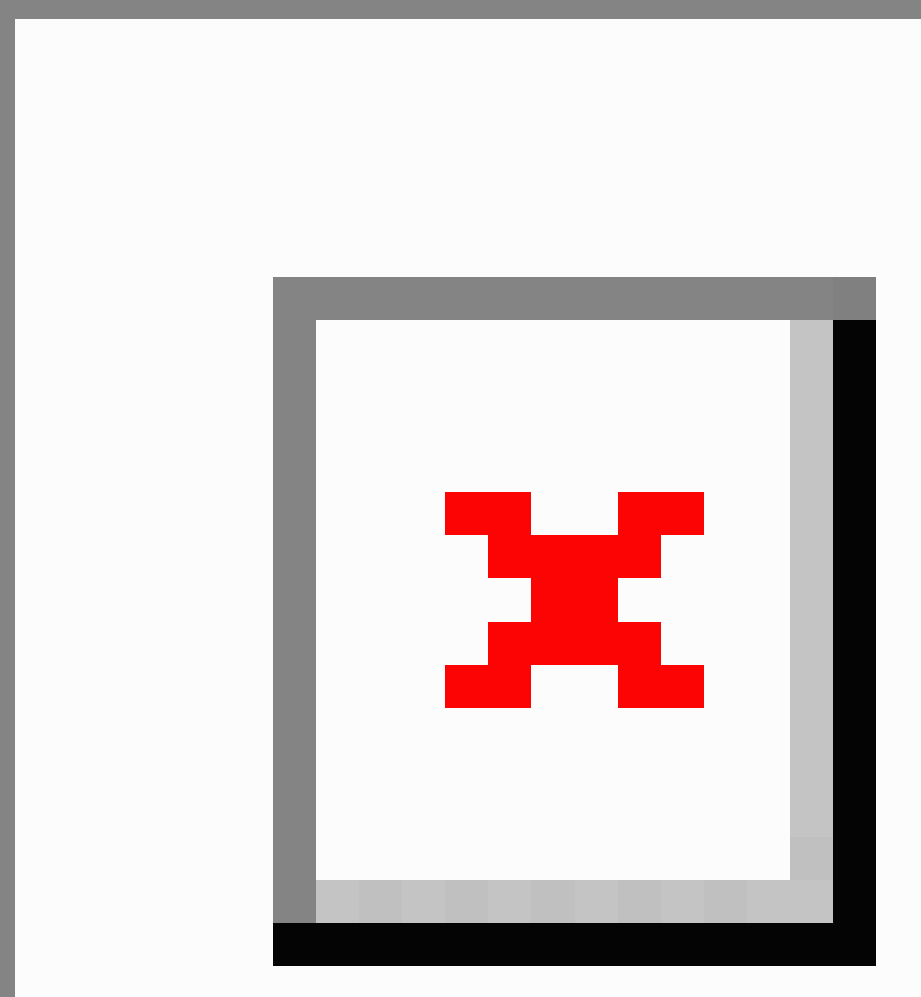
Figure 3. The importance rankings of feature variables for the XGBoost